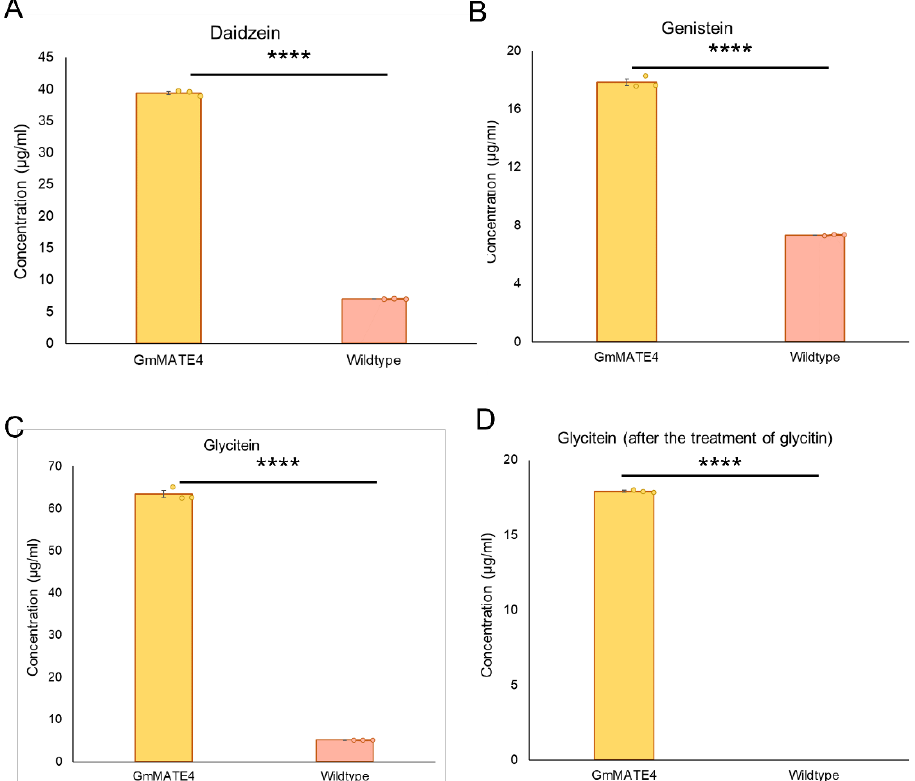
Figure 4. Uptake assays of isoflavones. The isoflavones detected in the yeast cells after the treatments of: ( A ) daidzein; ( B ) genistein; ( C ) glycitein; or ( D ) glycitin. Error bar: standard error from three technical repeats. Student’s t test (two-tailed) was performed to compare the isoflavone uptake capacity between the constructs. **** indicates p < 0.0001. The experiments were performed twice with similar results.